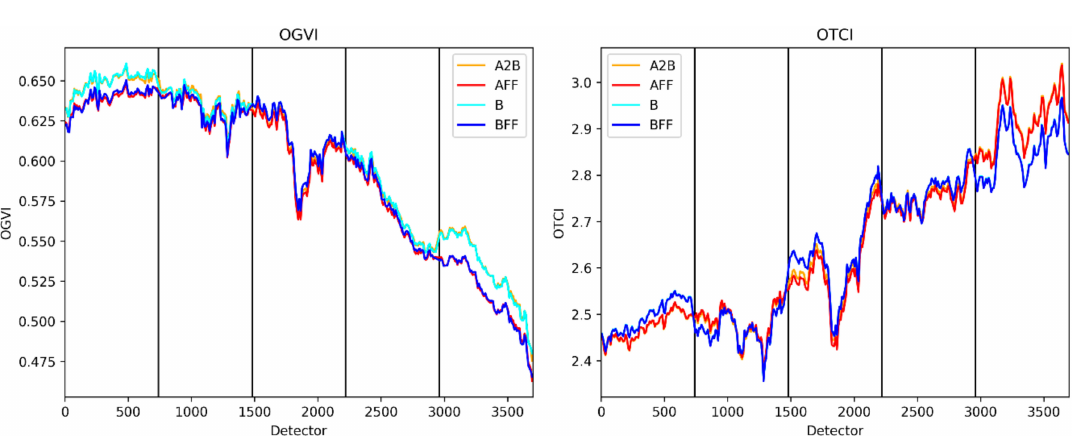
Figure 21. ALT-averages of OGVI ( left ) and OTCI ( right ) over AMZ for the four calibration